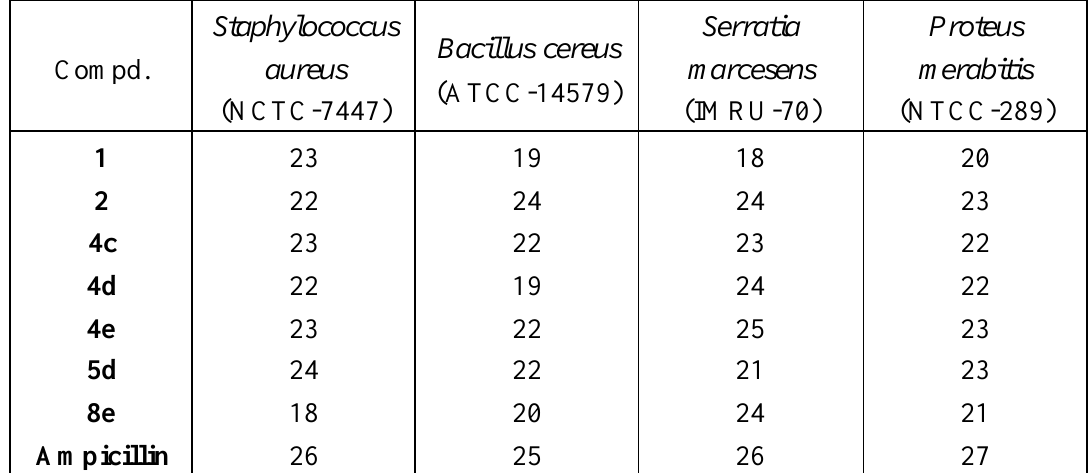
Table I: Antibacterial activity of some compounds